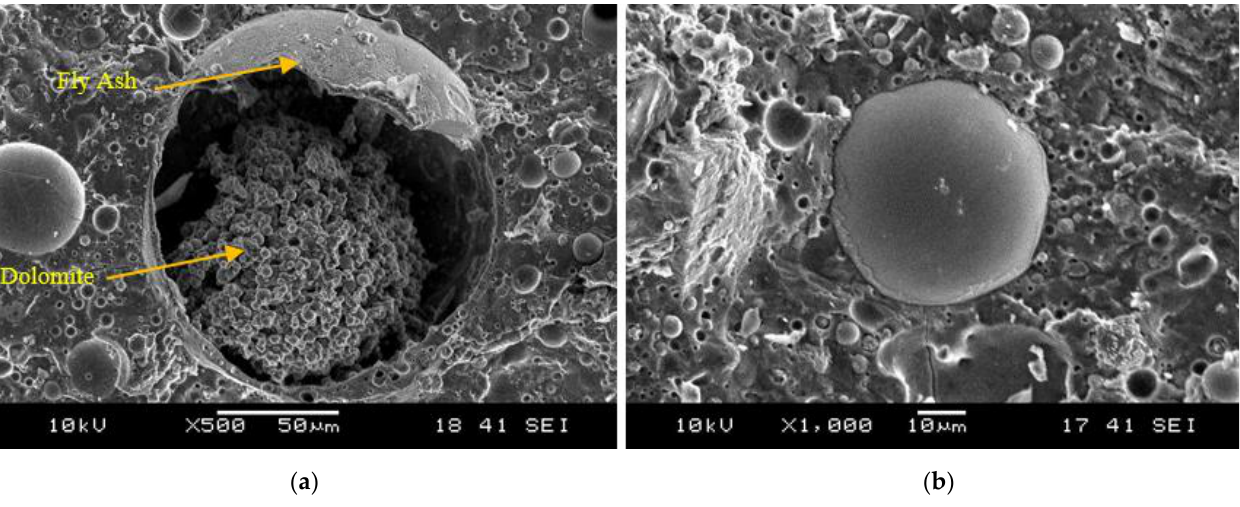
Figure 7. The morphology of ( a ) reaction between fly ash and dolomite and ( b ) gelation process of the geopolymer.